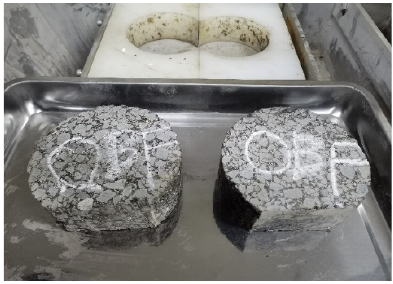
Figure 11. SGC specimen.